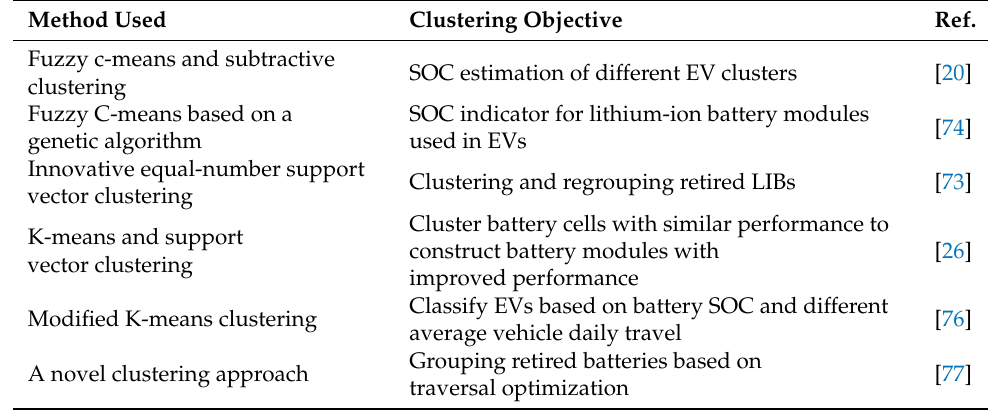
Table 5. Summary of clustering methods along with their objectives for EV battery grouping.